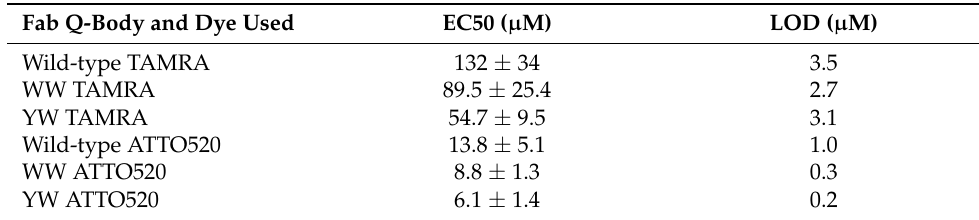
Table 2. EC50 and LOD of Fab-type Q-bodies to His 6 peptide.